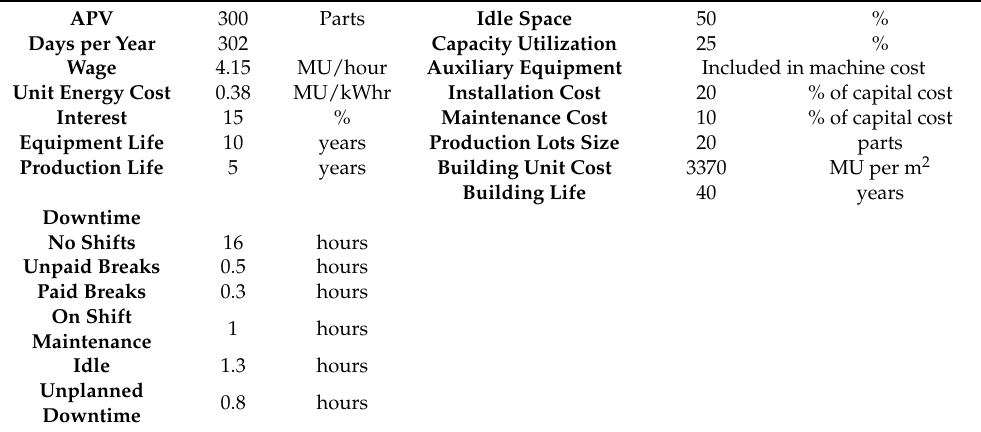
Table 2. Assumed plant conditions for the hood